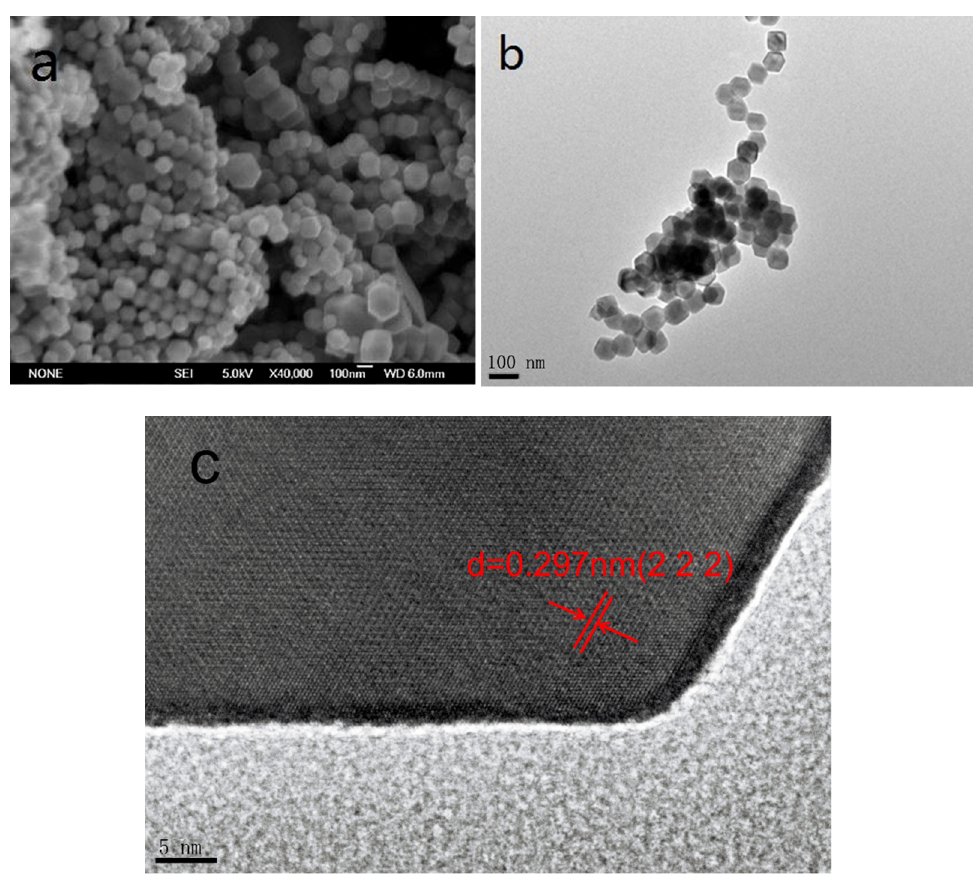
Figure 3. ( a ) SEM image of Fe 3 O 4 ; ( b ) TEM image of γ -Fe 2 O 3 /WO 3 · 0.5H 2 O; ( c ) HRTEM image of a single particle of γ -Fe 2 O 3 /WO 3 · 0.5H 2 O.